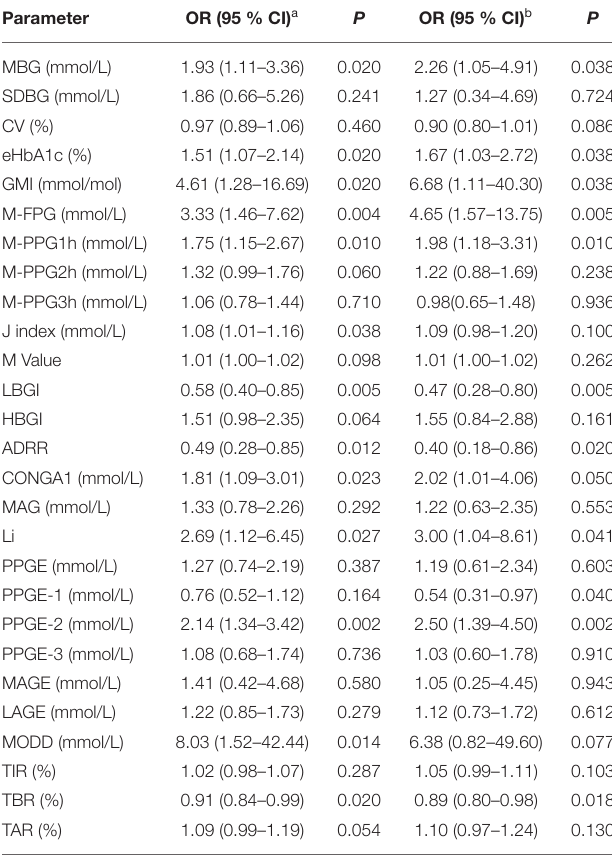
TABLE 3 | Logistic regression analysis of not achieving longevity and CGM indices.